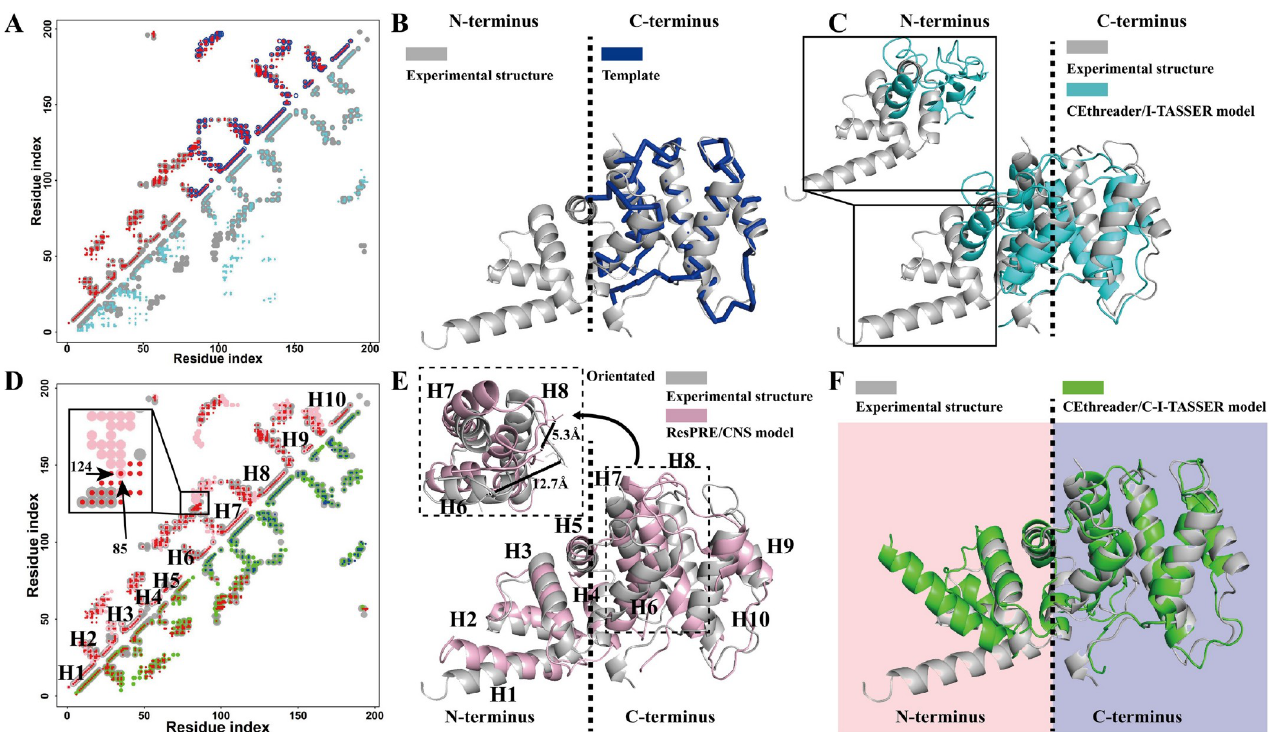
Fig 5. Modeling results for the ARF guanine-nucleotide exchange factor 1 (PDB ID: 1re0B). (A) Overlay of contact maps for the native query (gray circles), ResPRE-predicted contacts (red circles), CEthreader detected template (blue circles), and CEthreader/I-TASSER model (cyan circles). (B) The structure superposition of the templates (blue) and the native (gray). (C) The structure superposition of the CEthreader/I-TASSER model (cyan) and the native (gray). (D) Overlay of contact maps for the native query (gray circles), ResPRE-predicted contacts (red circles), overlapped contacts between the ResPRE prediction and the CEthreader detected template (blue circles), the ResPRE/CNS model (pink circles), and the CEthreader/C-I-TASSER model (green circles). (E) The structure superposition of the ResPRE/CNS model (pink) and the native (gray). (F) The structure superposition of the CEthreader/C-I-TASSER model (green) and the native